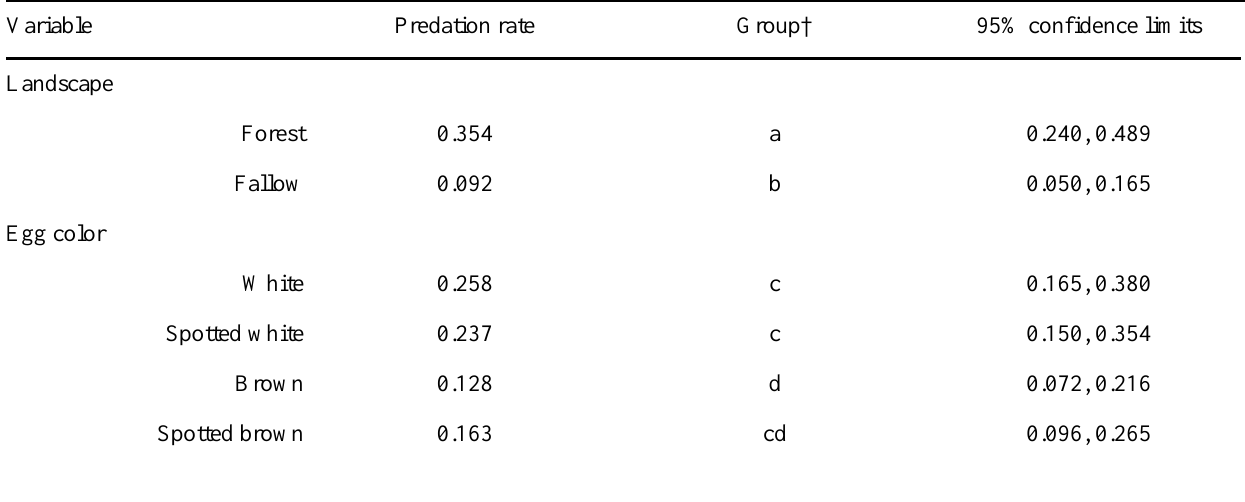
Table 2. Predation rates of all predators combined by landscape across all egg colors and by egg color across all